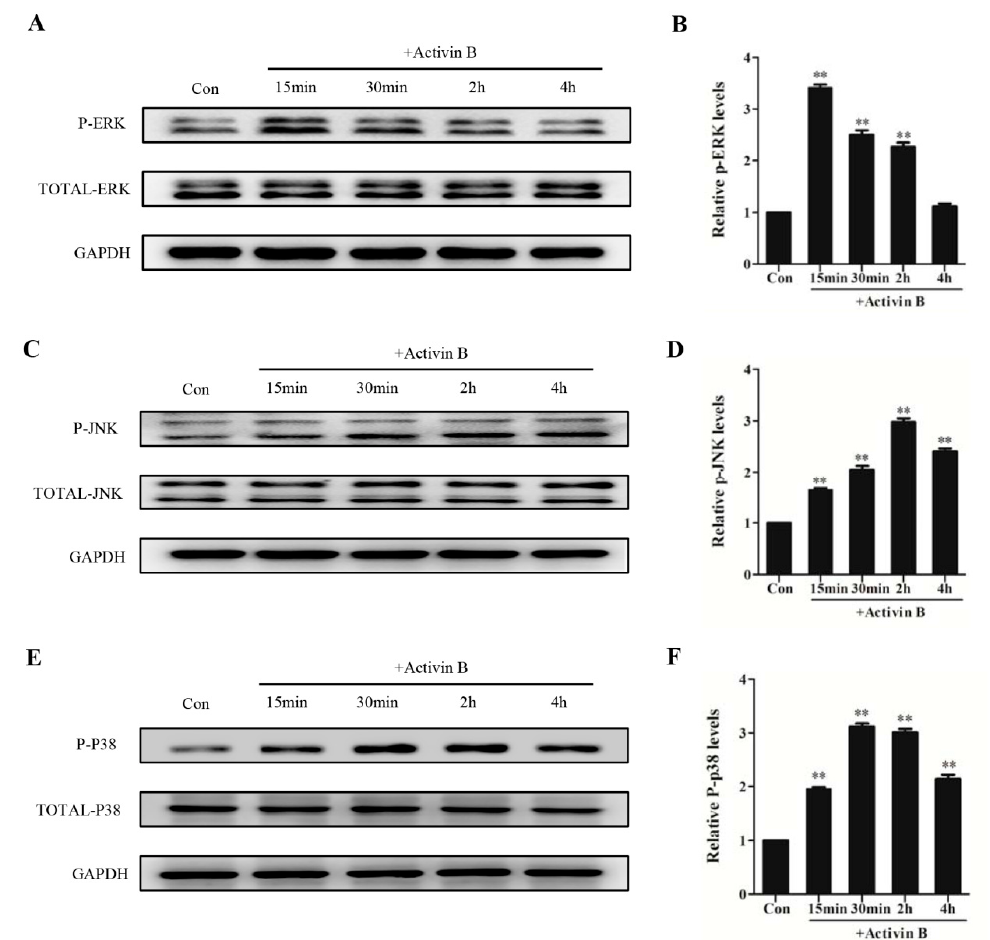
Figure 3. Activin B stimulated JNK, ERK, and P38 phosphorylation in hair matrix cells. ( A , B ) The plot and the relative quantification of the expression of phosphorylation of ERK in HHGMCs treated with 10 ng/mL Activin B for 15 min, 30 min, 2 h, and 4 h. ( C , D ) The plot and the relative quantification of the expression of phosphorylation of JNK in cells treated with 10 ng/mL Activin B for different times. ( E , F ) The plot and the relative quantification of the expression of phosphorylation of P38 in cells treated with 10 ng/mL Activin B for different times. * p < 0.05; ** p < 0.01, compared with the PBS group. Three independent experiments were conducted per data point. All error bars indicate SEM.